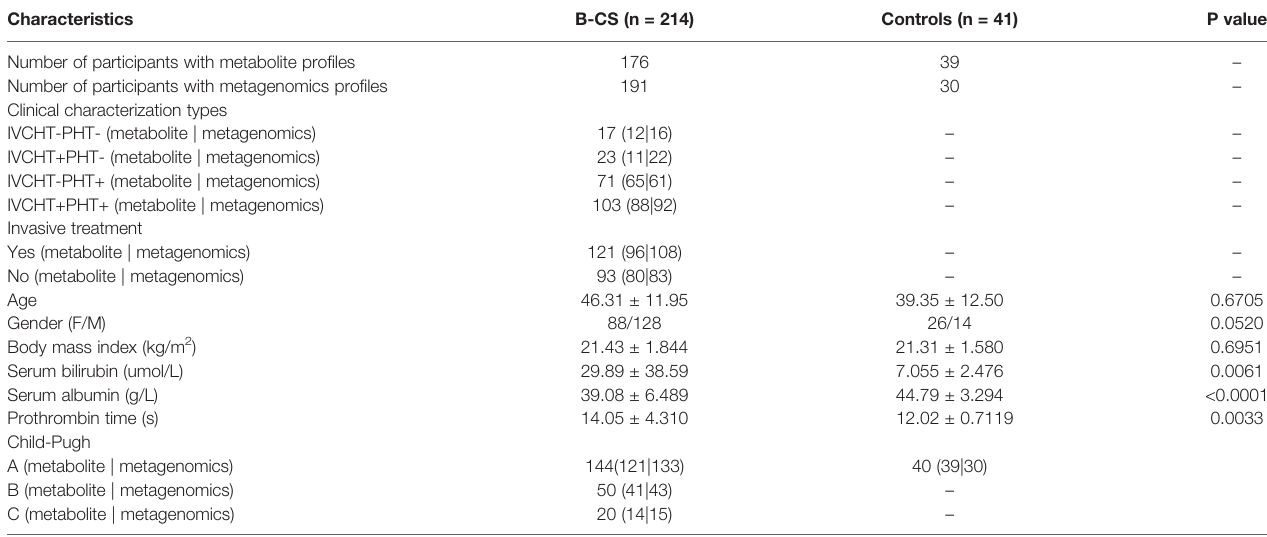
TABLE 1 | Clinical characteristics of patients with B-CS and healthy controls.